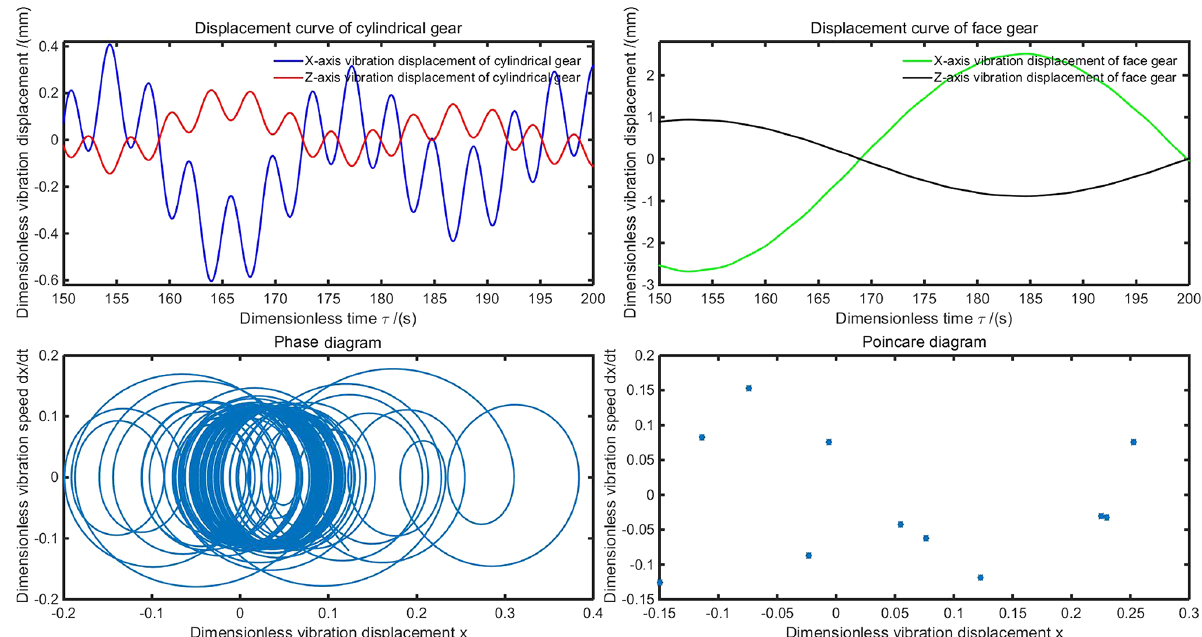
Figure 23. Displacement, phase, and Poincare diagrams of nonlinear system with excitation frequency